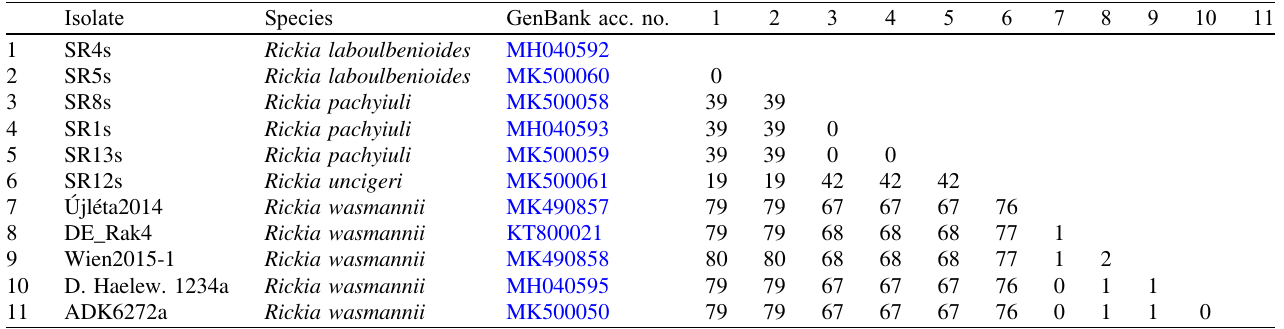
Table 8. Distance matrix of the aligned 28S rDNA sequences. Isolate GenBank acc.